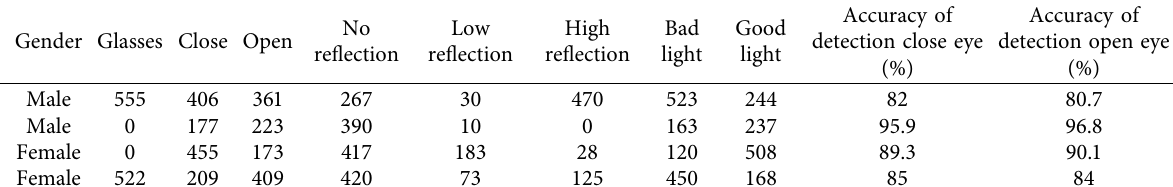
Table 5: Offline MRL eye dataset analysis.